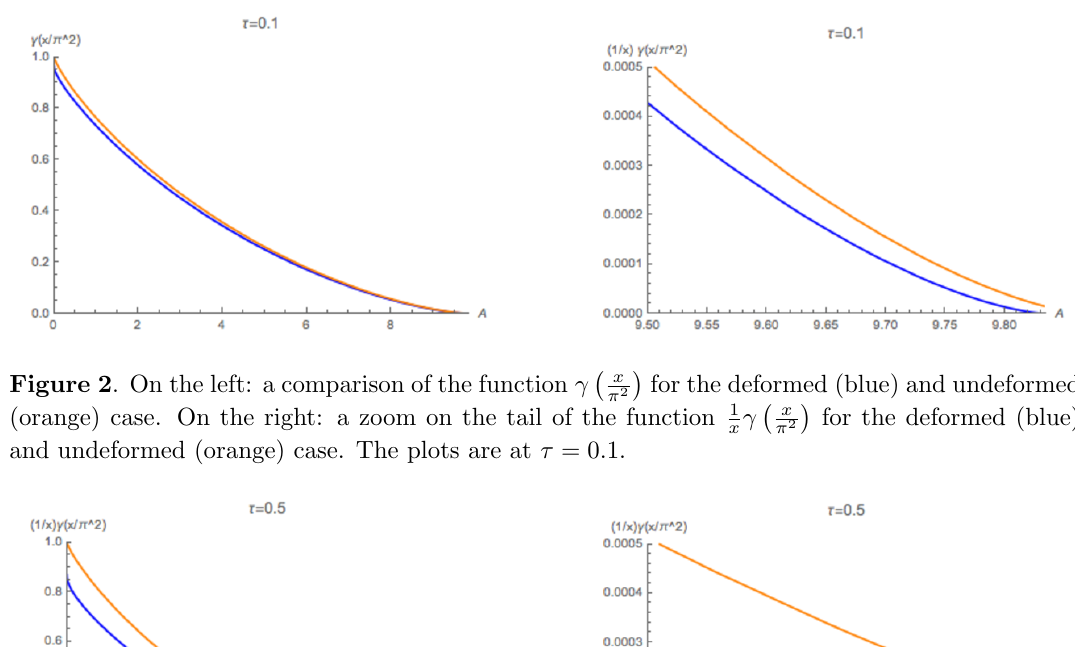
Figure 3 . On the left: a comparison of the function (cid:13) (orange) case. On the right: a zoom on the tail of the function 1 and undeformed (orange) case. The plots are at (cid:28) = 0 :